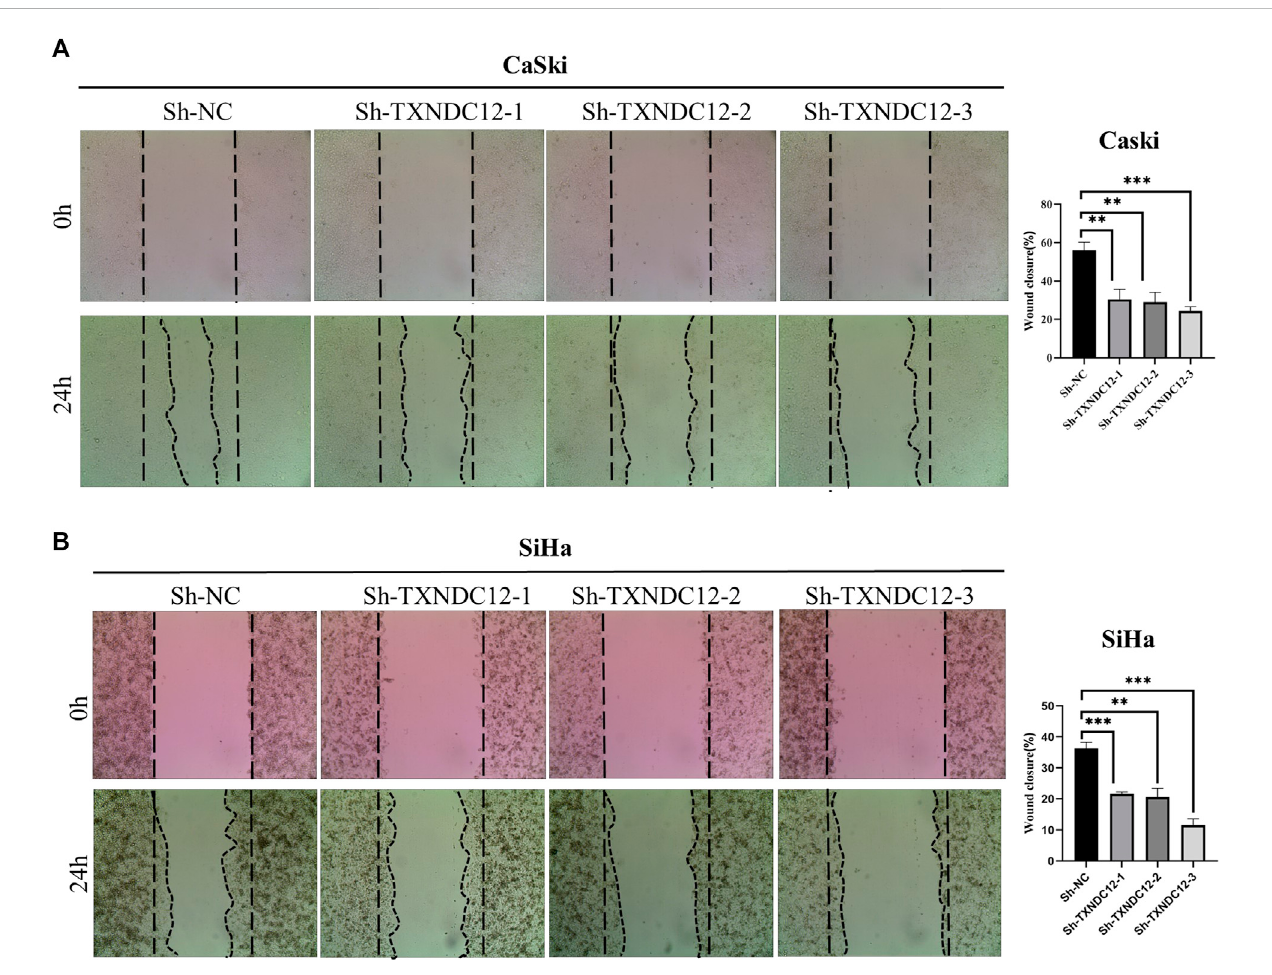
FIGURE 9 Scratch wound healing assay with CaSki cell line (A) and SiHa cell line (B) . (* < 0.05, ** < 0.01, *** < 0.001).